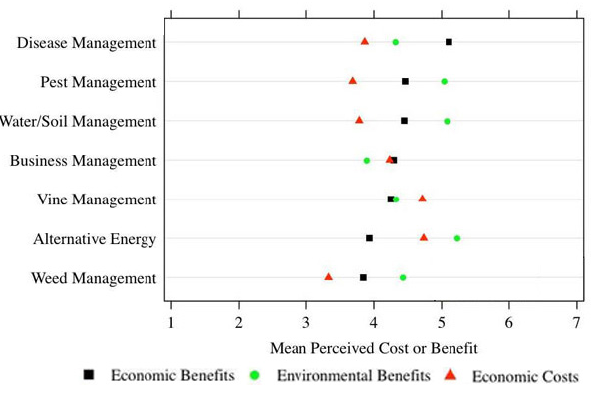
Fig. 1. Mean economic costs, economic benefits, and environmental costs for each category of